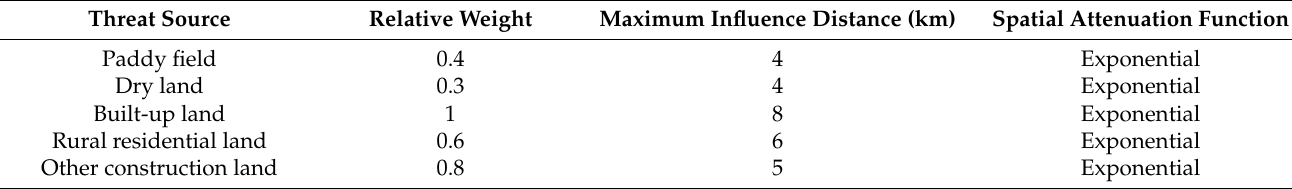
Table 2. Threats’ weight and the maximum distance of